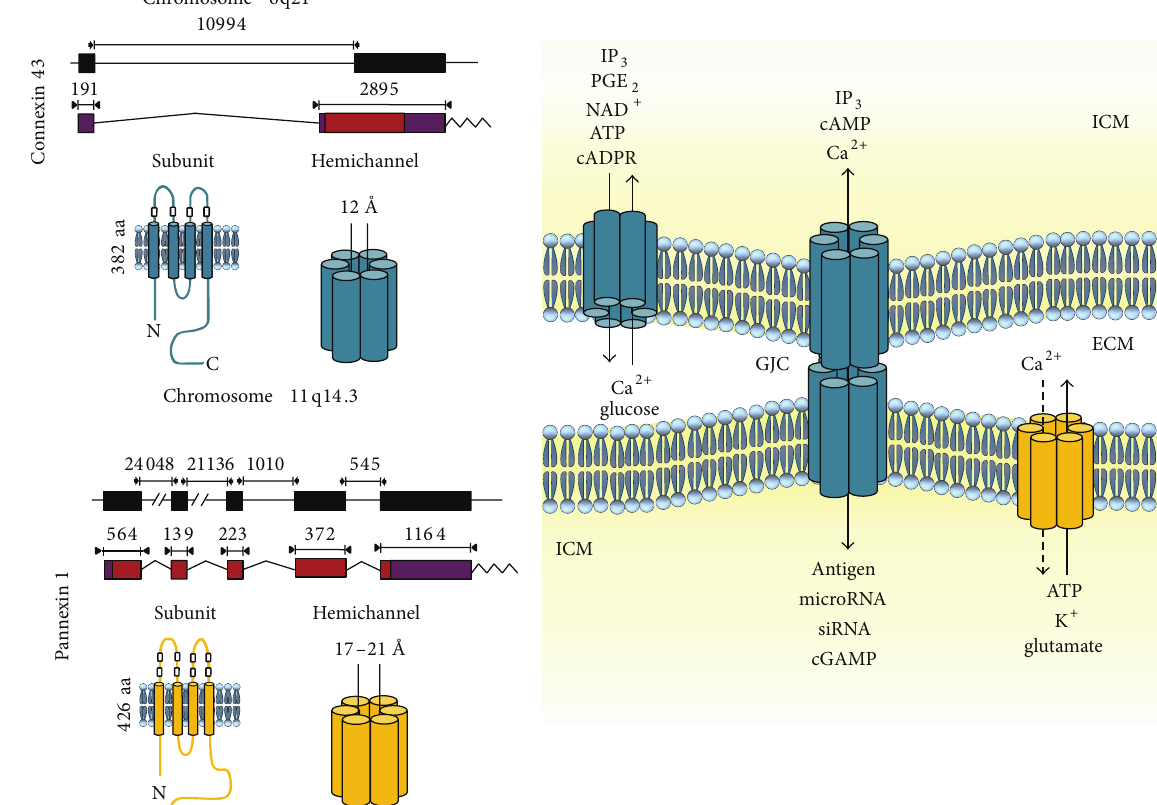
Figure 1: Connexin 43 and pannexin1 at gene and protein levels. Left: a diagram depicting the genomic regions, mRNA, and membrane topology of human connexin 43 (Cx43, top left) and pannexin 1 (Panx1, bottom left). Genomic loci are represented by black boxes that stand for the corresponding exons. mRNA diagrams representing the exons as coding protein regions (red boxes) and 3 󸀠 - and 5 󸀠 -non-coding areas (purple boxes) are shown. The intron lengths are indicated in the schemes of genomic loci, and exon sizes are indicated in the mRNA diagrams. In the membrane topology the white squares indicate extracellular cysteine residues of each protein. Six protein subunits constitute a hemichannel (HC), which has different pore sizes. Right: two adjoining cells forming a gap junction channel (GJC) at the cell interface. Each cell presents HCs formed by Cx43 or Panx1. Arrows denote the bidirectional communication with the intracellular milieu (ICM) for GJCs and the extracellular milieu (ECM) for HCs; some immunorelevant molecules are shown. Dotted line for Ca 2+ permeating Panx1 HCs indicates that this phenomenon is not fully